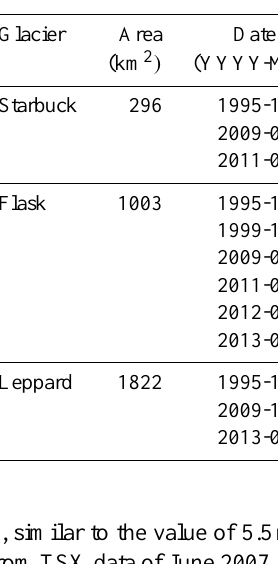
Table 3. Drainage area above the flux gate, velocities at the center of the flux gate ( V c ) , discharge across the flux gates, and difference of discharge vs. 1995; for glaciers draining into Scar Inlet ice